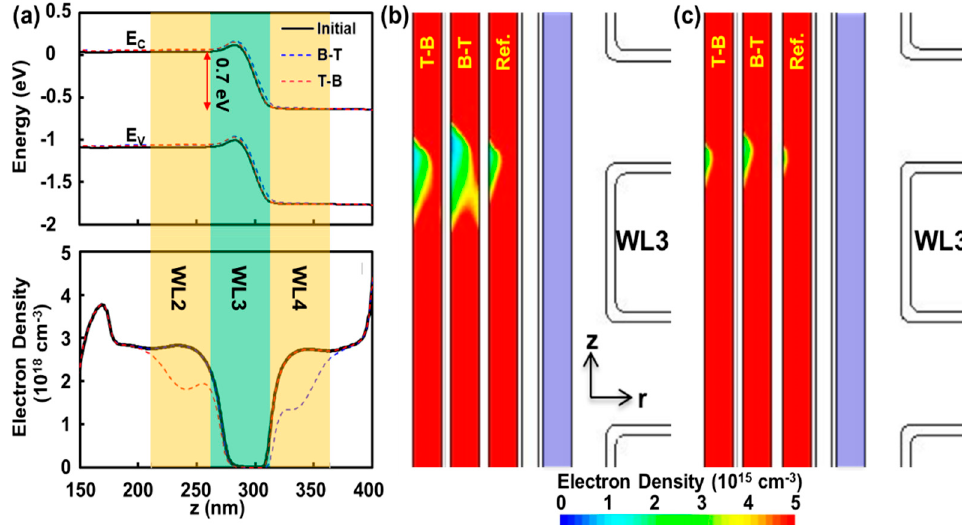
Figure 4. Poly-silicon channel information during reading operation ( V WL3 = − 1 V, V READ = 7 V, V BL = 0.7 V, V CSL = 0 V) ( a ) band diagram: Top, electron carrier concentration; bottom, following the z-axis (r = 38 nm). The potential of 0.7 V through the bit line is mainly applied to the reading cell (WL3) since the adjacent cells are fully inverted with V READ = 7 V; hence they have negligible resistances. Consequently, WL4 should experience less inversion (by V READ − 0.7 V = 6.3 V) compared to WL2 (by V READ − 0 V = 7 V), which is reflected in electron density in the bottom figure. WL4 and WL2 have carriers of 1.3 and 1.9 (10 18 cm − 3 ) at the center, respectively. ( b ) Color plots of electron density for ‘initial’ reveal non-centered carrier bottleneck due to drain-induced-barrier-lowering (DIBL) effect. As a result, B-T; having the upper adjacent cell programmed, has the stronger interference compared to T-B with the lower adjacent cell programmed. The light blue region corresponds to trap-nitride layer (Si 3 N 4 ) ( c ) When V READ is increased to 8 V, the imbalance between B-T ( V READ − 0.7 V = 7.3 V) and T-B ( V READ − 0 = 8 V) is reduced.